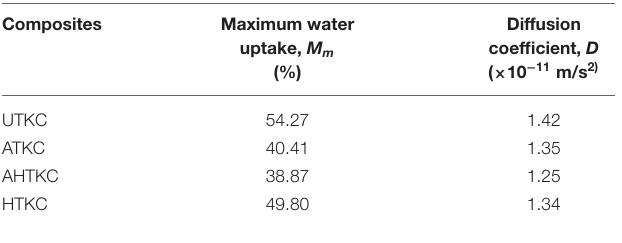
TABLE 5 | Water absorption properties of composites. Composites